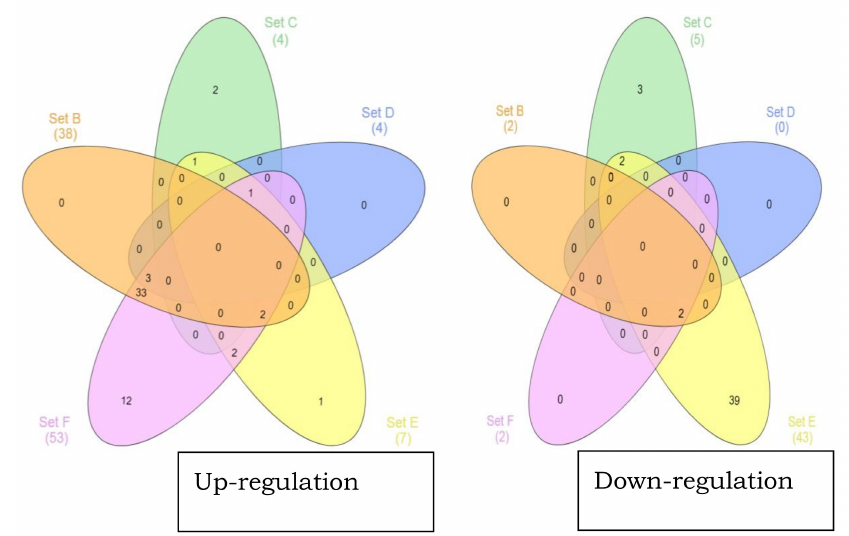
Figure 2. Venn diagram of the di ff erentially regulated proteins. The sum of the number of non-overlapping circles represents the total number of di ff erentially regulated proteins found only in that respective treatment; the overlapping parts of the circles indicate the di ff erentially regulated proteins common between the experimental groups.